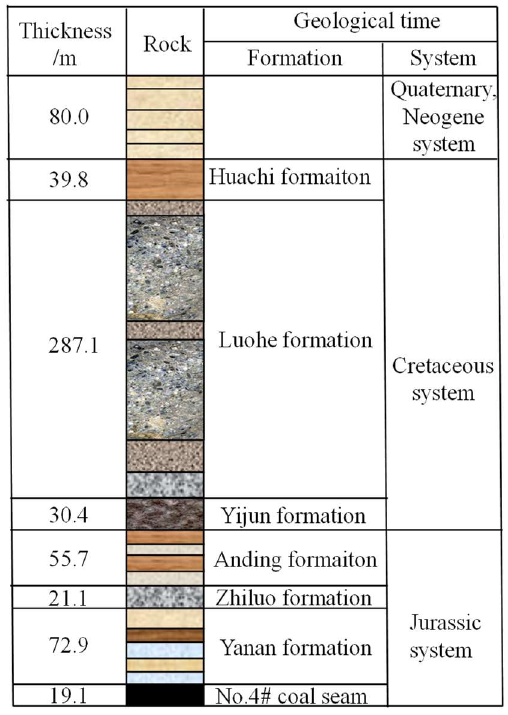
Figure 1. Stratum comprehensive columnar sketch